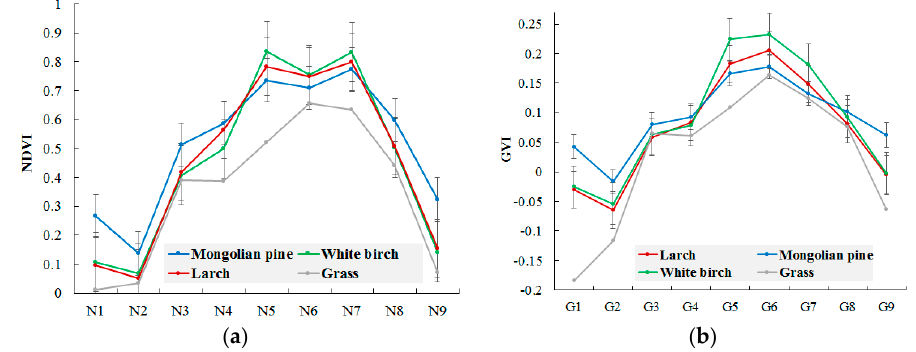
Figure 3. Trajectories of tree species and non-forest covers for NDVI ( a ) and GVI ( b ). Error bars are marked as ± standard error at each point.